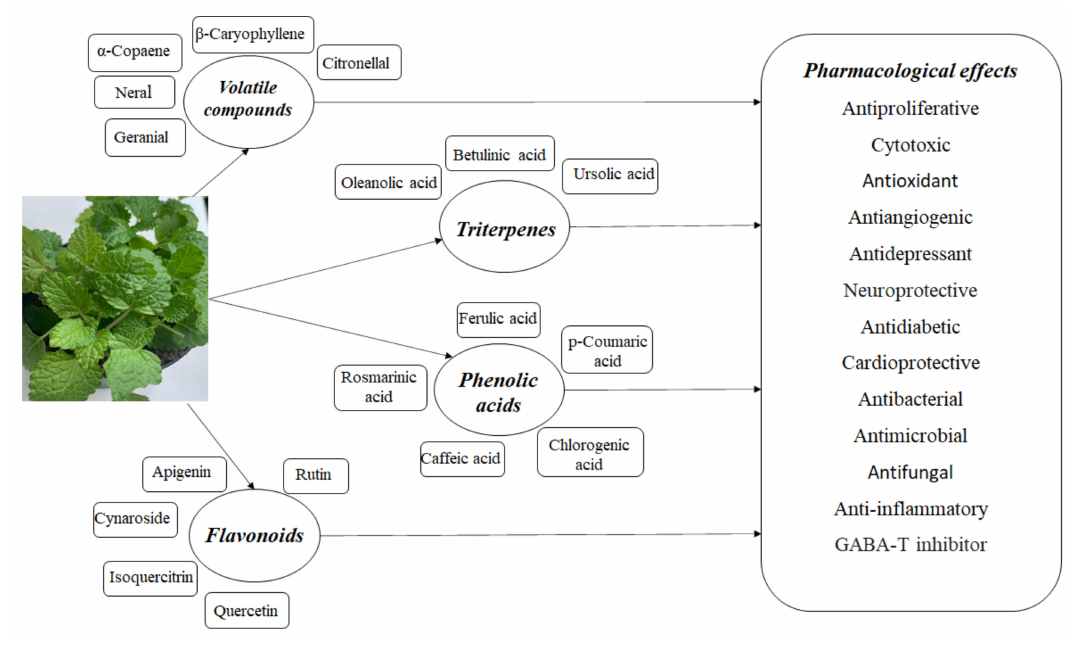
Figure 1. The composition of Melissa officinalis and its pharmacological